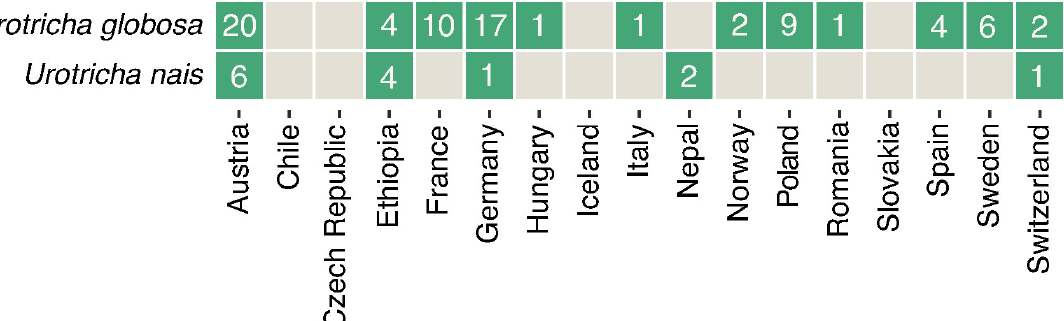
Figure 8. Distribution of the two Urotricha strains. Green squares indicate the occurrence of V4- and V9-markers in a country and the numbers indicate in how many lakes they were found per country. Detailed information about the investigated freshwater lakes can be found in Table S1 and [1].